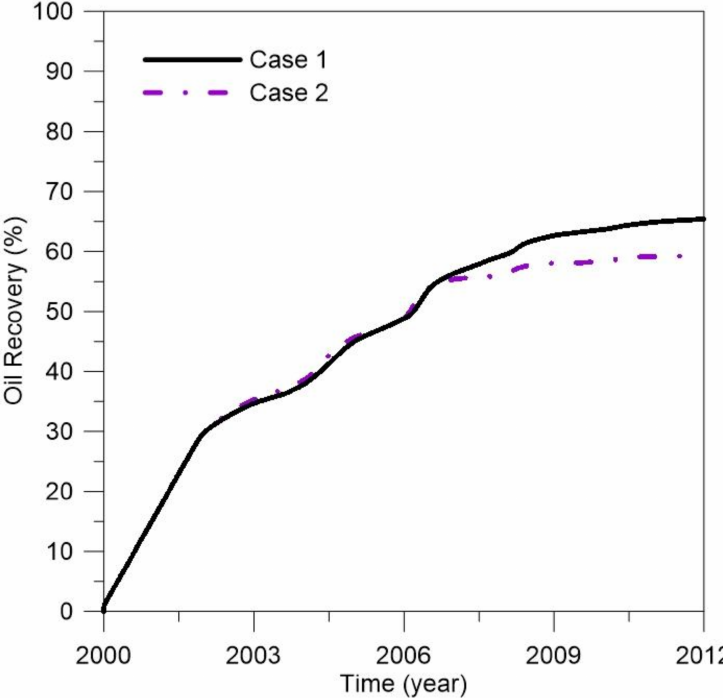
Figure 8. Oil recovery factor during the CO 2 and impure CO 2 WAG injection.